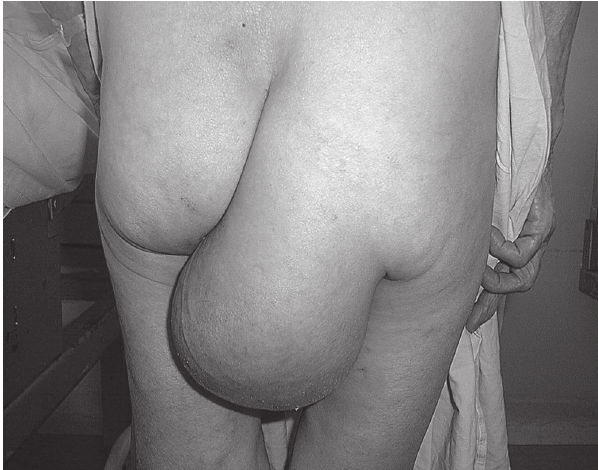
Figure 1 - An enlarging herniation in the right buttock area, partially reducible.